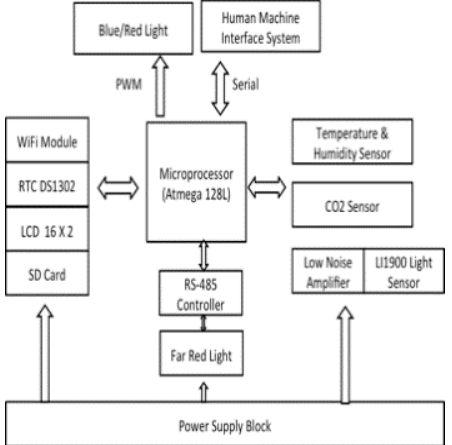
Figure 5. The climate control block diagram.